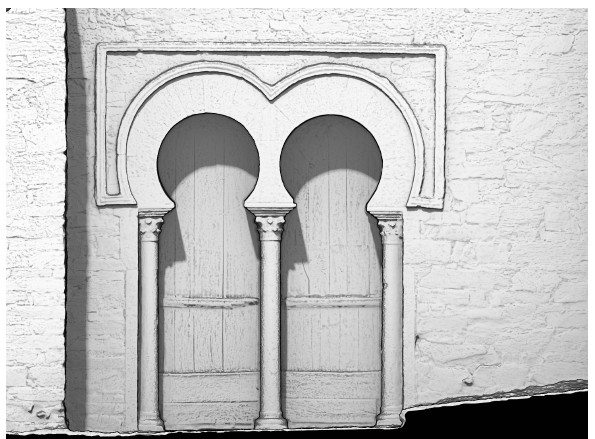
Figure 17: Automatic volumetric drawing generated by pro- cessing and composing some of the multiple layers with differ- ent edge detection methods (base RGB color information is re-